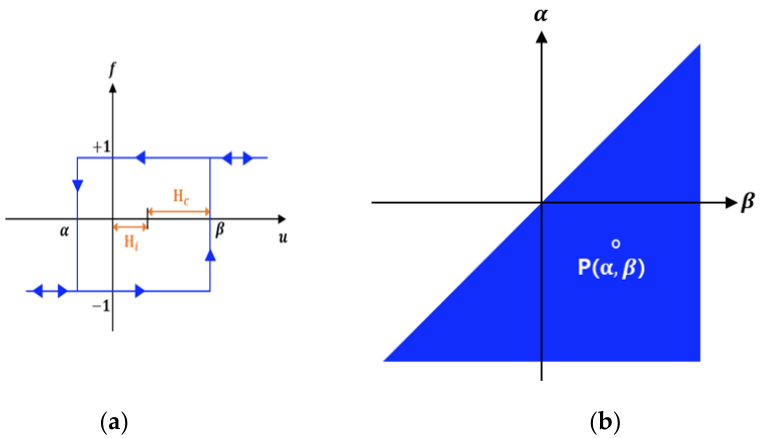
Figure 4. Unit hysteresis operator and Preisach plane: ( a ) unit hysteresis operator f; ( b ) Preisach